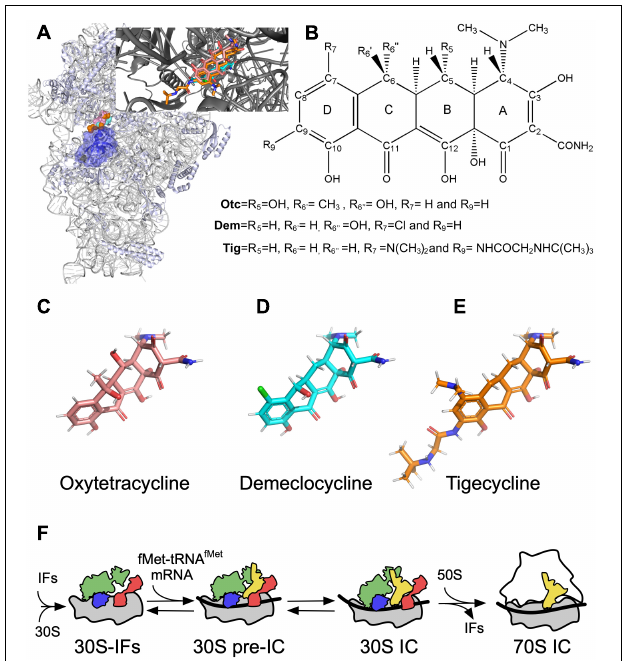
FIGURE 1 | Tetracyclines and translation initiation. (A) Overview of 30S ribosomal subunit and binding site of Tetracyclines. IF1 is shown in blue. Inset, close up of the tetracyclines interaction with the A site. The structures are drawn from PDB 5LMV (30S complex) (Hussain et al., 2016), and PDB 4YHH was used to align all Tetracyclines in the inset. (B) Tetracycline core chemical structure. (C) Oxytetracycline (Otc, pink). (D) Demeclocycline (Dem, sky blue). (E) Tigecycline (Tig, orange). (F) Scheme of the main steps of translation initiation in bacteria. IF3 (red), IF2 (green), and IF1 (blue) bind the 30S to form the 30S–IFs complex. Binding of the mRNA (black ribbon) and fMet-tRNA fMet (yellow) build the 30S pre-IC, which, upon decoding the start codon, rearranges to the 30S IC. The large 50S subunit can bind the 30S IC, triggering the dissociation of IFs and entering the elongation phase of protein